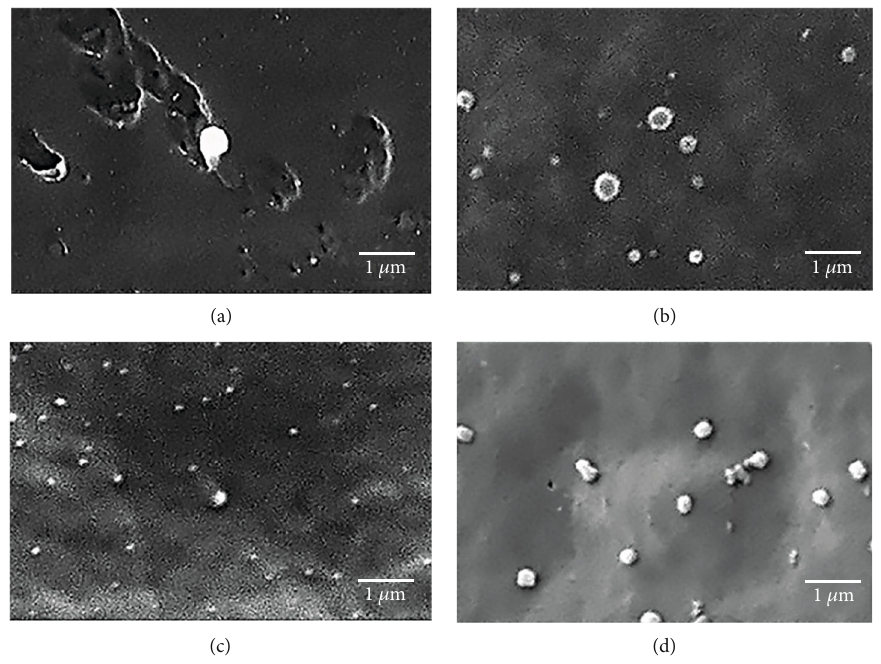
Figure 9: SEM images of S. aureus bio fi lm adhesion on (a) PSM50, (b) PSM40, (c) PSM30, and (d)